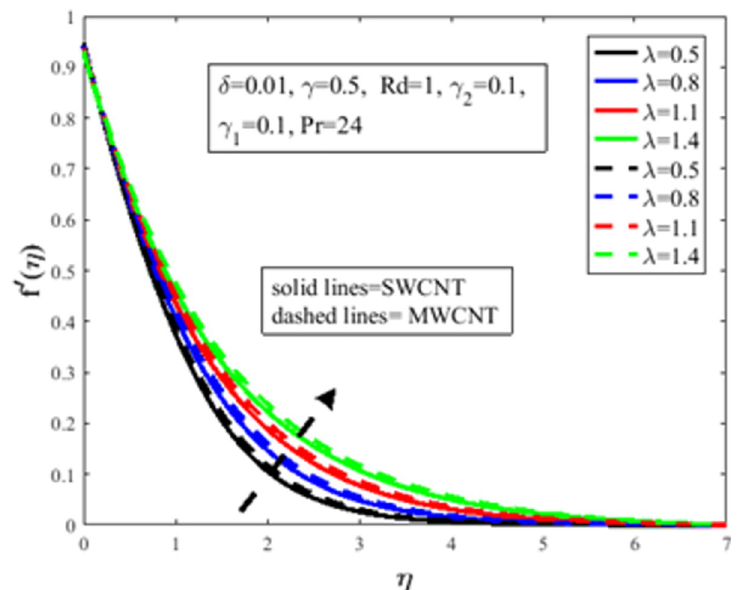
profile. The Bingham number γ effect on the domain of velocity is represented in Fig 5. The proportion of yield-stress to viscous-stress is the number of Bingham. It is noted that due to an increase in the shear-rate, the fluid viscosity increases. Physically, amplification in Bingham turns liquid into solids due to magnification in the fluid viscosity. The fluid then behaves like shear-thickening, which often diminishes the velocity of the fluid. Fig 6 revealed the effect of velocity slip γ on f 0 ( η ). Slip phenomenon occurs when the velocity of the nanofluid and the 1 surface is not the same. Physically, the slip phenomenon occurs due to roughness, wetness, and non-adhesives forces acting on the surface of the stretching sheet. That’s why they wander wall forces and adhesives forces are not acting on the fluid flow over the stretching sheet. As a result slip phenomenon occurs. In the presence of slip phenomenon, the nanofluid velocity flow over the surface declines which lessens the fluid velocity and f 0 ( η ). The portrayal of γ on shear stress field g ( η ) is shown in Fig 7. It’s noted that the shear stress field diminishes owing to amplification in γ . Physically for the fewer values of γ and λ , the fluid behaviour is shear thickening. Both γ and λ are prominent factors of the Reiner-Philippoff fluid parameter and are somehow related to each other. The behaviour of the fluid is shear-thinning λ < 1 which lessens the fluid velocity and amplifies the stress field. As a result g ( η ) augments. Fig 8 depicts the outcome of λ on g ( η ). Fluid parameter λ is the ratio of zero shear rate to the infinite sheat rate. Physically a positive variation in the infinite shear rate depreciates the fluid parameter λ .